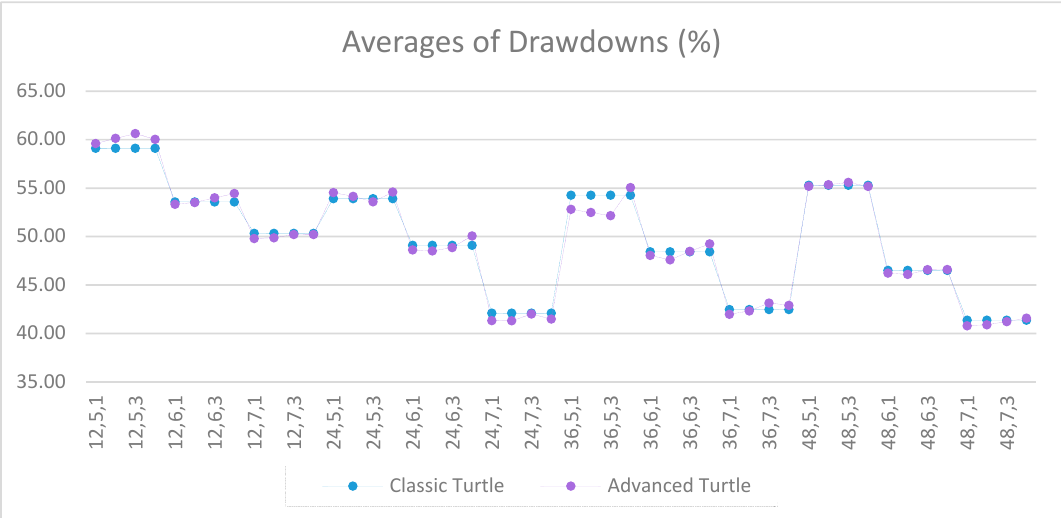
Figure 16. Averages of drawdowns as percentage of equity between the classic and the advanced Turtle systems for every combination of N, X, Y for the slow parameters (80, 160), where X ≥ 5.